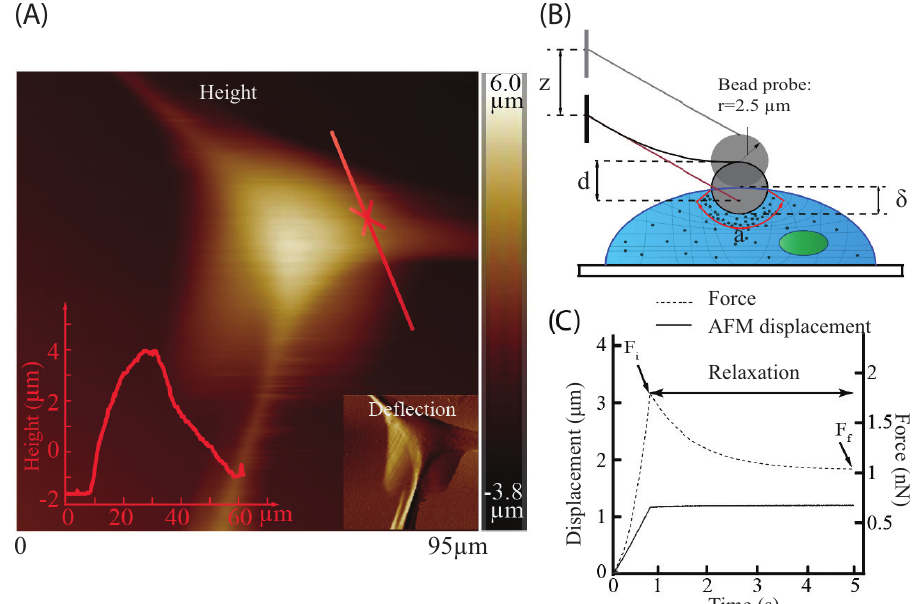
Figure 5. ( A ) AFM topography image of an MDCK cell, where the red cross represents the measurement site. ( B ) AFM measurement of the cells with a sphere probe (radius 2.5 µ m), where the area in red represent the probe–cell contact size. ( C ) The probe–cell interaction force and AFM displacement ( z ) profile during the force–relaxation process, where F i is the probe–cell interaction force at the beginning of the relaxation process (i.e., the end of the indenting process), and F f is the force at the end of the relaxation